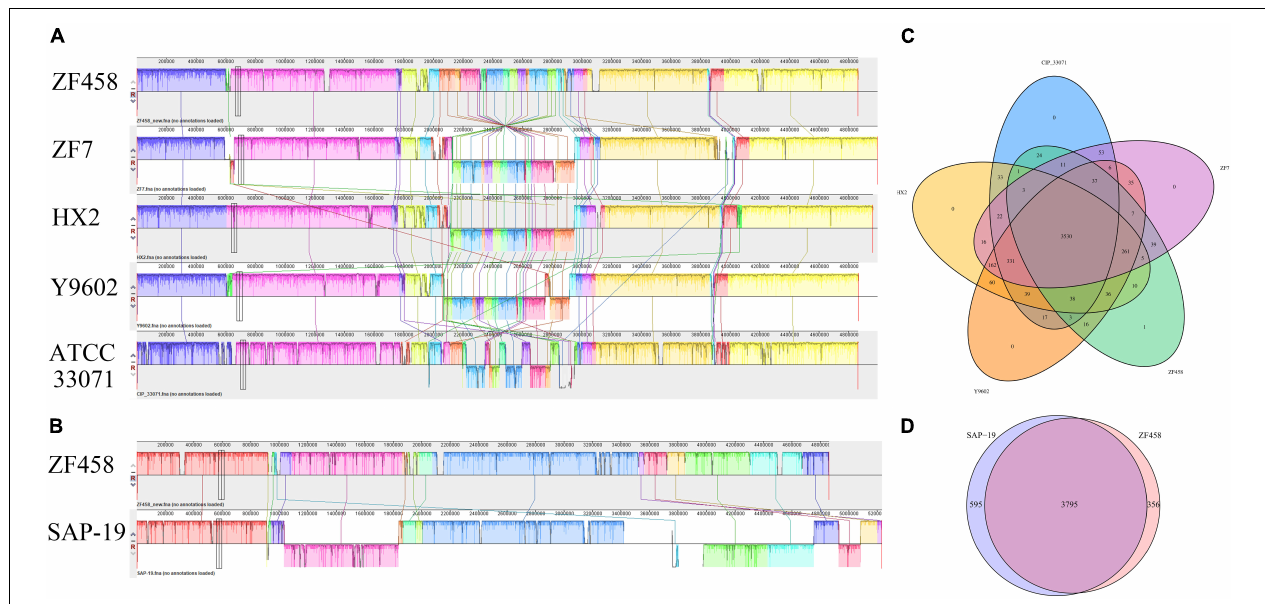
FIGURE 3 | Global alignment of the genome sequence of completely sequenced R. aceris ZF458 against five other Rahnella genome sequences. (A) Mauve progressive alignment of the ZF458, ZF7, HX2, Y9602, and ATCC 33071 genomes. (B) Mauve progressive alignment of the ZF458 and SAP-19 genomes. ZF458 genome was used as the reference genome. Boxes with the same color indicate syntenic regions. Boxes below the horizontal strain line indicate inverted regions. Rearrangements are indicated with the colored lines. The scale is in nucleotides. (C) Venn diagram showing the numbers of shared and unique Clusters of Orthologous Genes among ZF458, ZF7, HX2, Y9602, and ATCC 33071 genomes. (D) Venn diagram showing the numbers of shared and unique Clusters of Orthologous Genes between the ZF458 and SAP-19